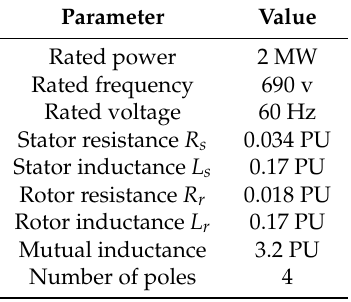
Figure 3. Schematic diagram of the doubly fed induction generators (DFIG). Table 3. Doubly fed induction generators (DFIG) wind turbine data.